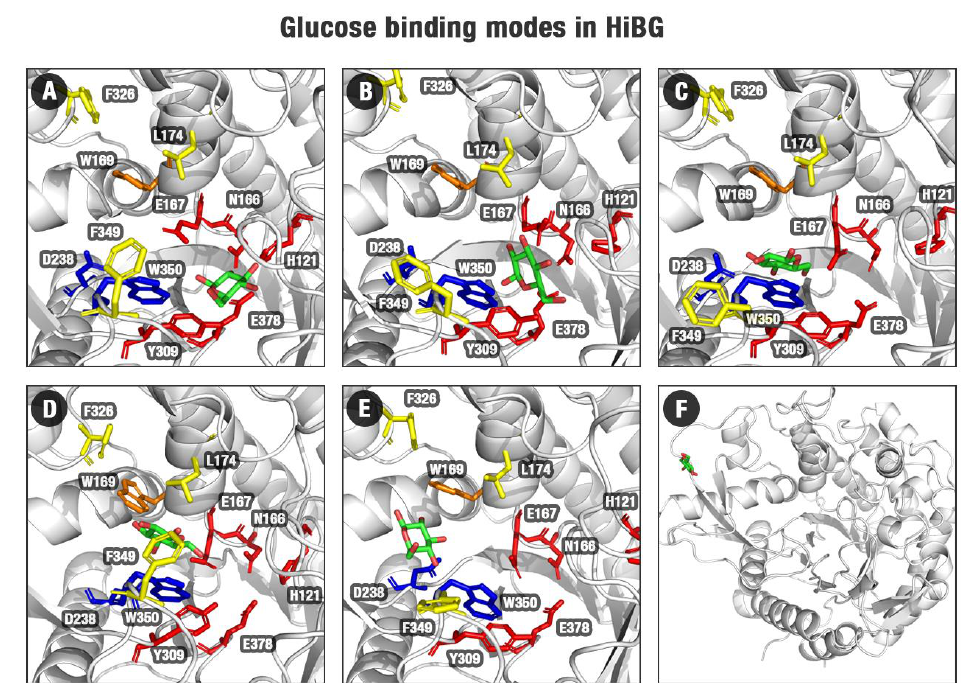
Figure 3. Binding modes for HiBG in complex with glucose of the GH1–glucose FEL (Figure 2B) for the regions 1 ( A ), 2 ( B ), 3 ( C ), 4 ( D ), 5 ( E ), and 6 ( F ). Protein structures are shown in gray, subsite − 1 (red sticks), subsite + 1 /+ 2 (yellow sticks), D238 / W350 (blue sticks), W169 (orange sticks). The poses (selected from the minima at the FEL from Figure 2B) show a probable exit path for glucose from the HiBG active site.